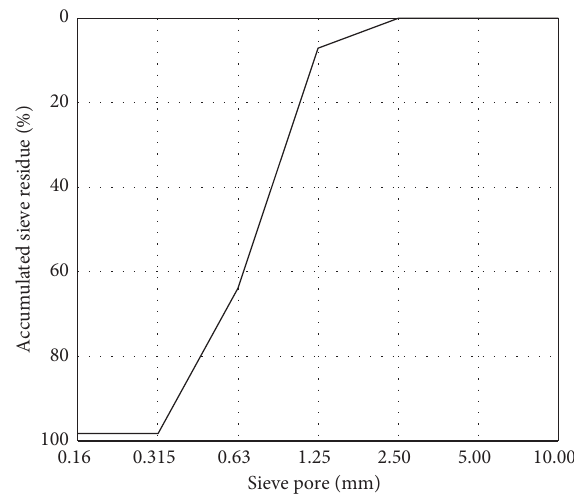
Figure 2: Grading curve of